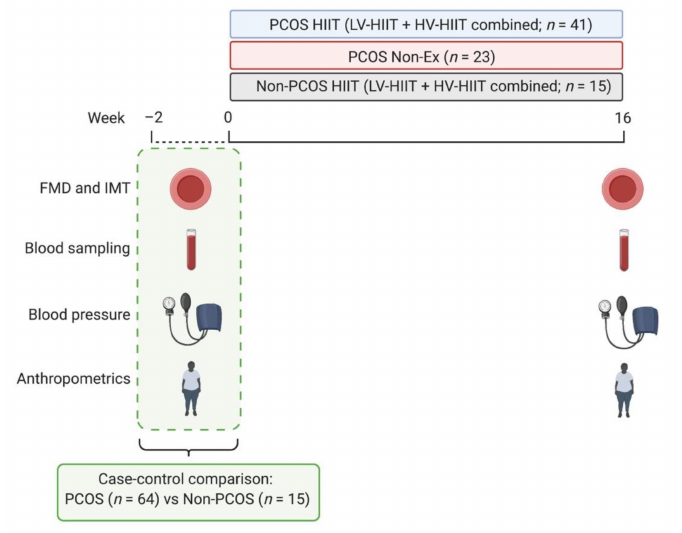
Figure 1. Study protocol. Women without polycystic ovary syndrome (Non-PCOS) were matched for age body mass index (BMI) to women with polycystic ovary syndrome (PCOS). Low-volume